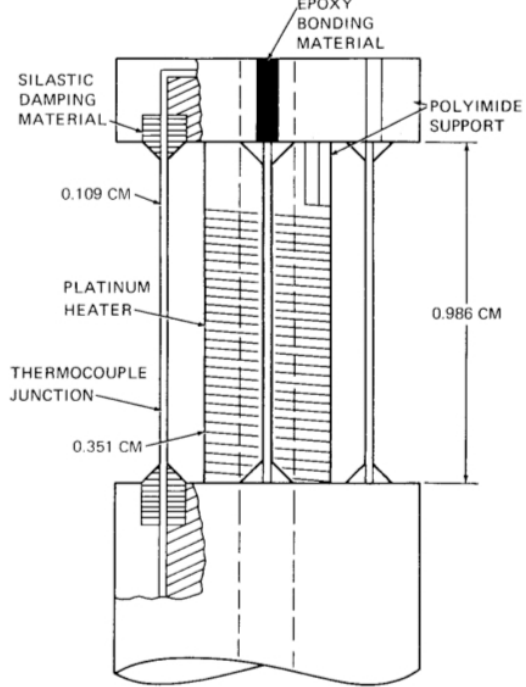
Figure 2. Quadrant sensor design (Hess et al., 1977).